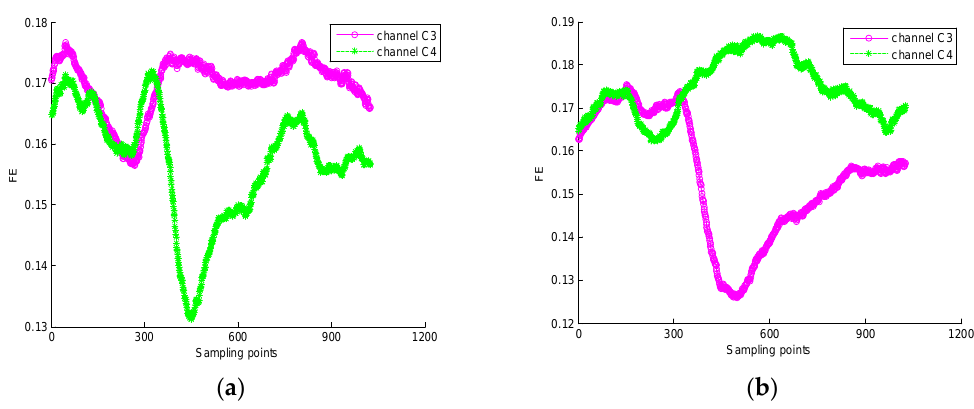
Figure 4. ( a ) The mean FE time series of MI-EEG on channels C3 and C4 for imaginary left hand movement; ( b ) the mean FE time series of MI-EEG on channels C3 and C4 for imaginary right hand movement.